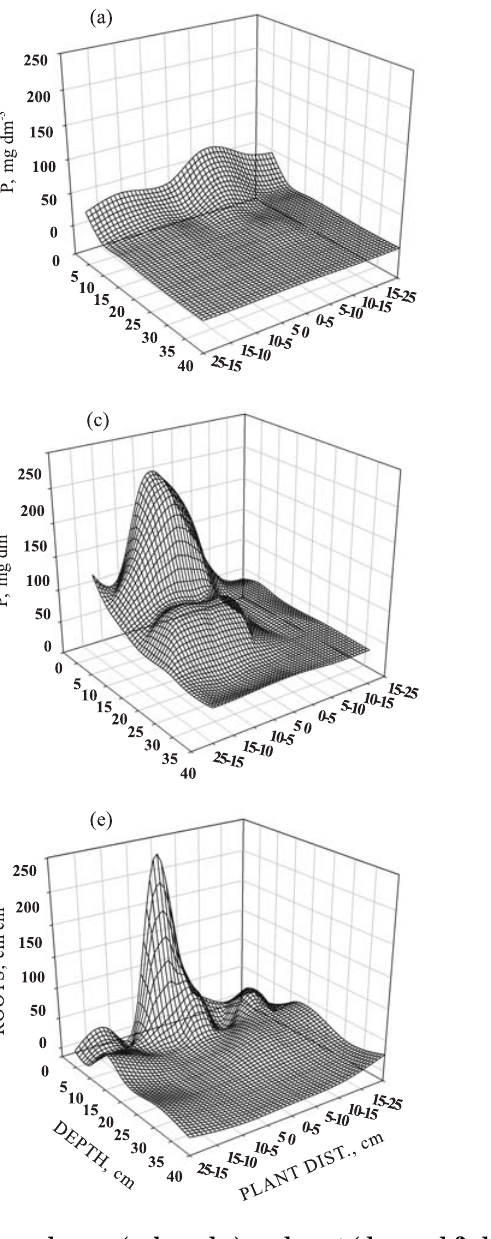
Figure 3. Phosphorus (a, b and c) and root (d, e and f) distribution at corn grain filling period, in a Rhodic Paleudult soil profile under tillage systems: no tillage-broadcast, no-tillage-row and strip-strip, respectively, for 18 years, 2006/2007 growing season (Representative monolith of the